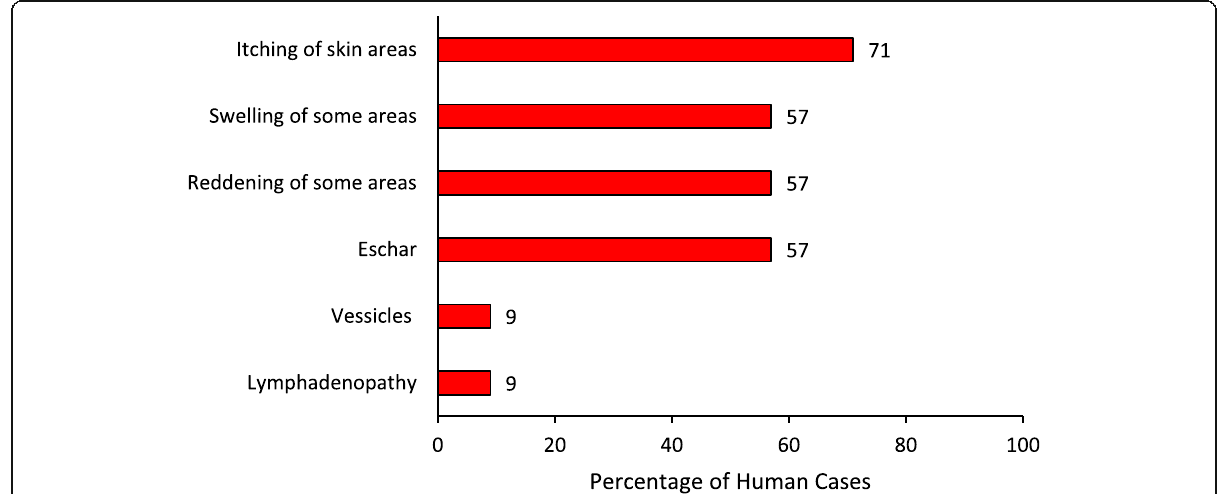
Fig. 1 Distribution of cutaneous anthrax signs and symptoms among 14 case-persons in Rhino Camp Sub-county, Arua District, Uganda, January – May, 2018